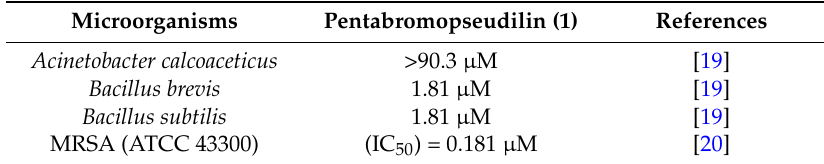
Table 1. Antibacterial activity of pentabromopseudilin expressed as Minimum Inhibitory Concentration (MIC) or half maximal inhibitory concentration (IC 50 ) in µ M.